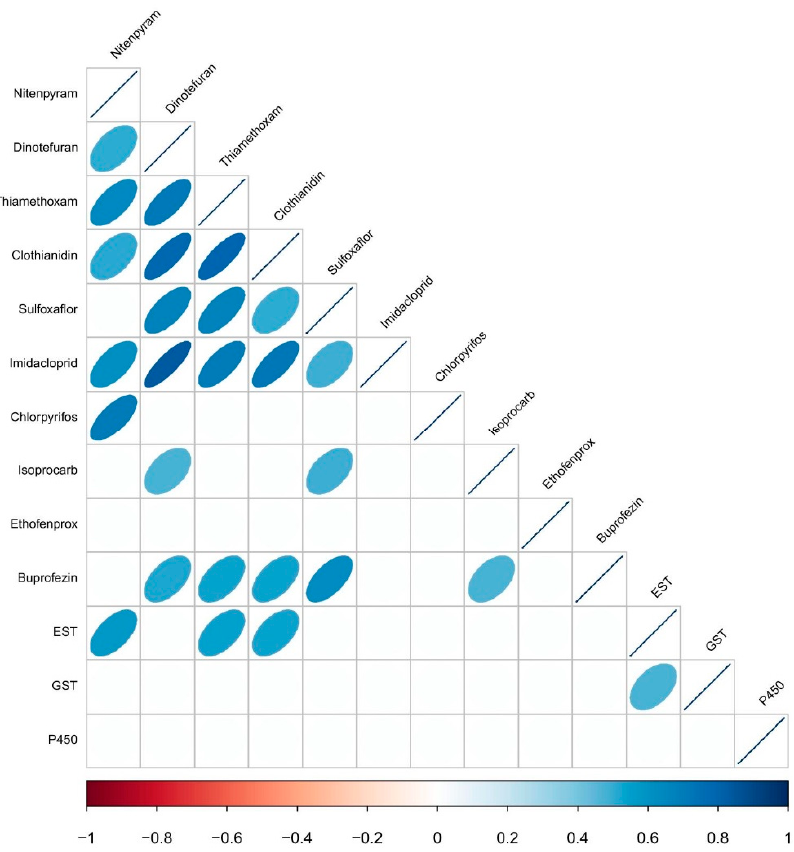
Figure 3. Correlations between the LC 50 values of the tested insecticides and the enzyme activities of the field populations of S. furcifera . Correlations are based on linear Spearman correlation coefficients. The scale color of the filled squares indicates the strength of the correlation (r) and whether it is negative (red) or positive (blue). Only significant correlations with p < 0.05 are shown.